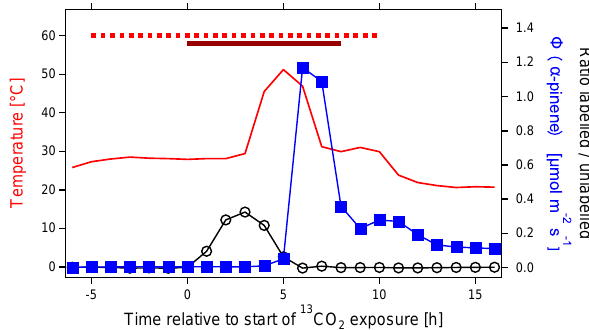
Fig. 2. α -pinene emissions from Scots pine under thermal stress (blue squares, right-hand scale). Open circles show the labelling ra- tio ( R iso ) of α -pinene molecules calculated according to Eq. (1) (black circles, right-hand scale). The red line shows the chamber temperature (left-hand scale). The dashed red bar indicates the pe- riod of illumination (PPFD=800µmolm − 2 s − 1 ) and the brown bar the period of 13 CO 2 exposure.